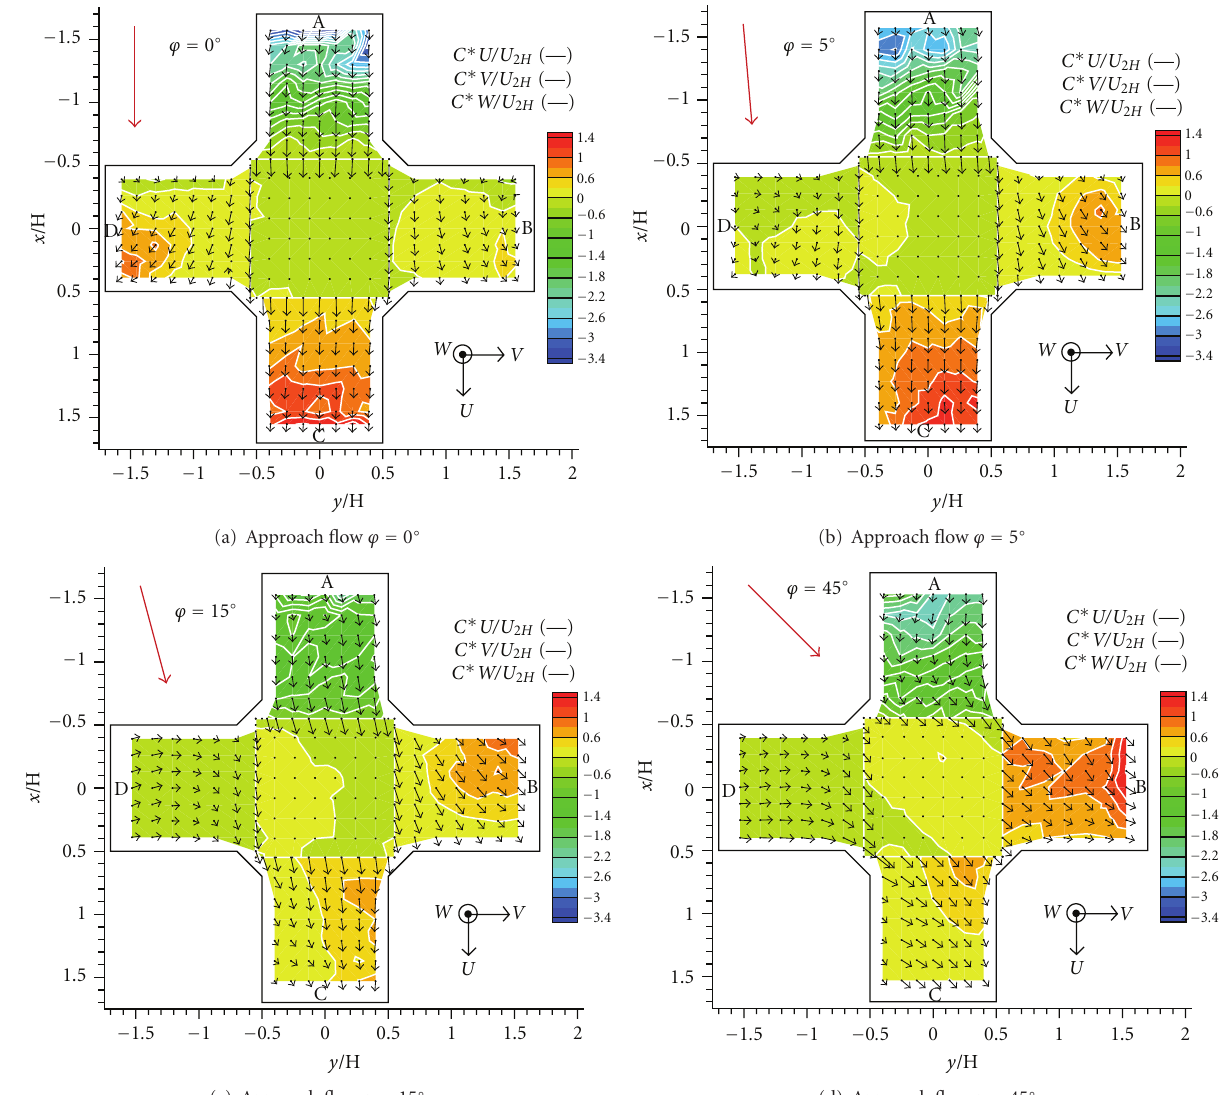
Figure 9: Horizontal and vertical dimensionless advective flux of passive contaminant with horizontal velocity vectors for four angles of the approach flow direction.